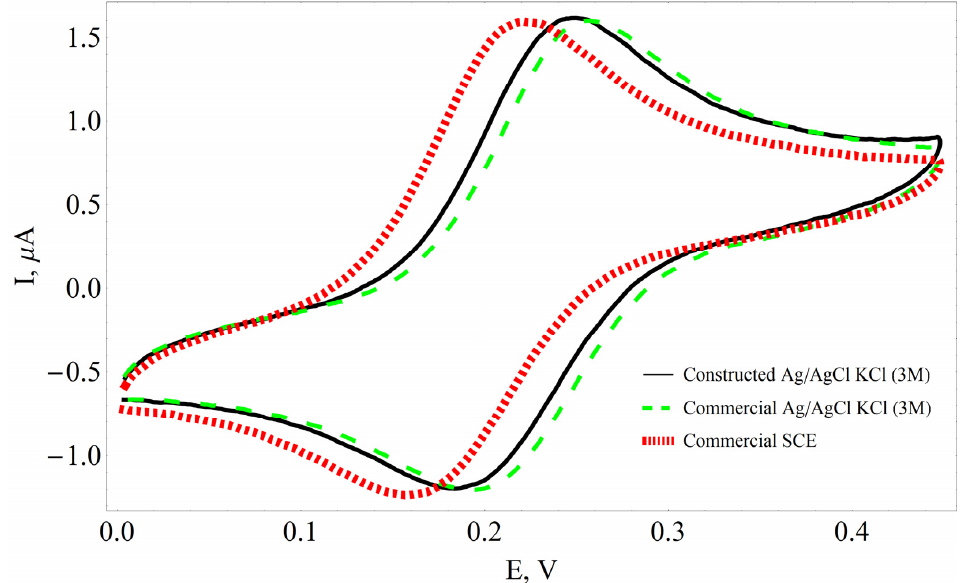
Figure 3. Cyclic voltammograms recorded using different types of reference electrodes. CV recorded in 0.1 mM hydroxymethylferrocene (HMF) in WBS, pH 7.0. The potential sweep rate is 100 mV/s.